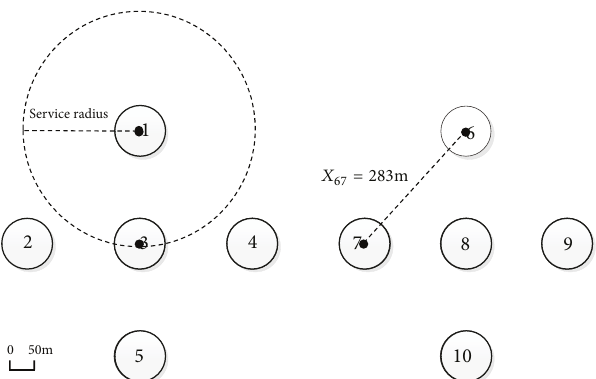
Figure 4: Illustration of the network with ten virtual candidate